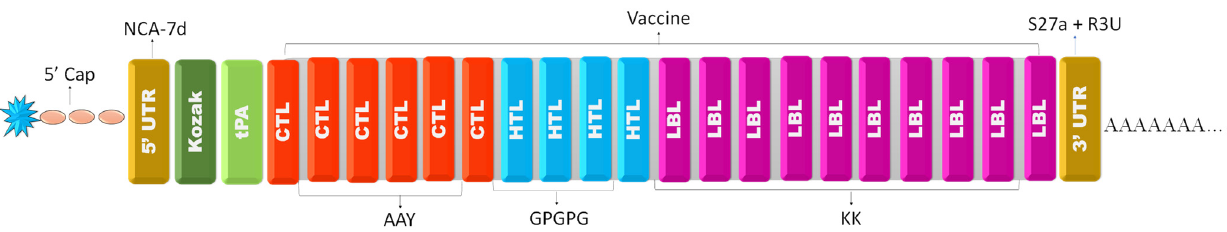
Figure 7. The final vaccine construct, blue with light Pink (5 ′ cap), brown (5 ′ UTR and 3 ′ UTR), light-dark green (Kozak Sequence), light green (Signal proteins), red (CTL epitopes), blue (HTL epitopes), purple (LBL epitopes), light gray (EAAAK, AAY, GPGPG, and KK linkers), and gray (Poly A tail).